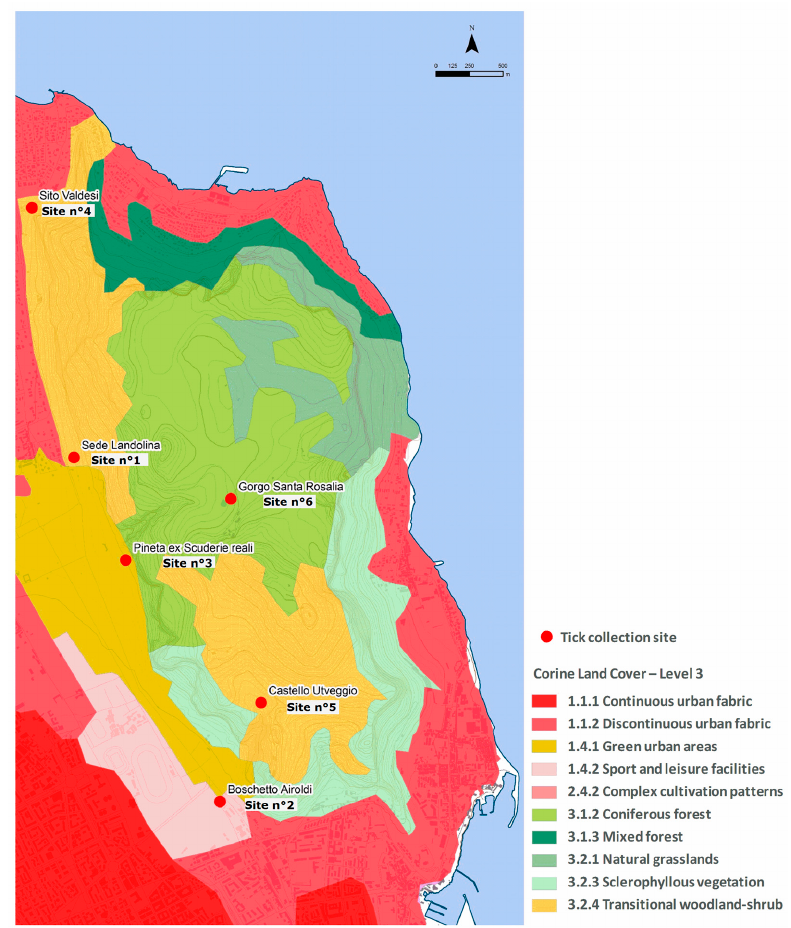
Figure 3. Corine Land Cover (2006). Land use.